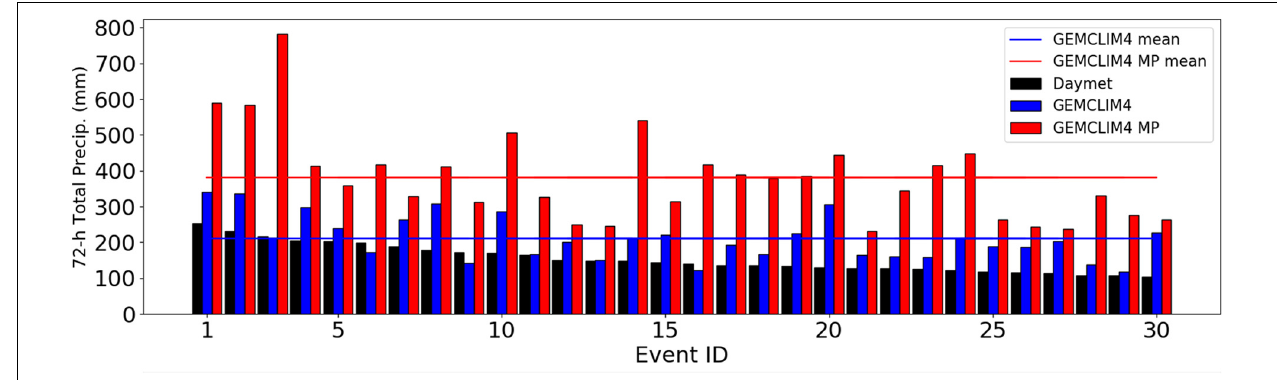
FIGURE 4 | Maximum of regional-averaged 72-h precipitation over Metro Vancouver for the 30 selected extreme precipitation events.